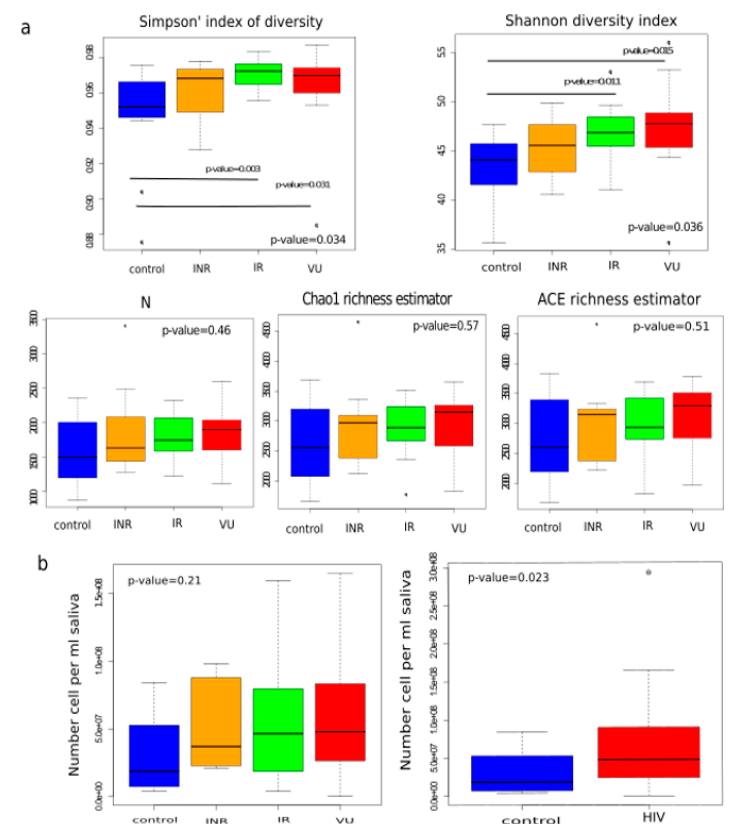
Figure 3. Alpha diversity and bacterial load in saliva. ( a ) Simpson’s index of diversity, Shannon diversity index, number of OTUs observed ( N ), Chao1 richness estimator, and Abundance-based Coverage Estimator (ACE) in the four groups. ( b ) Bacterial load expressed as number of cells per mL of saliva in the four groups. and bacterial load expressed as number of cells per mL of saliva in HIV-infected individuals (HIV) and controls. To calculate di ff erences across groups, we used the Kruskal–Wallis test ( p -value = 0.05) and, for di ff erences between groups, we used the Wilcoxon rank-sum test ( p -value = 0.05). INR, immunological ART non-responders (yellow); IR, immunological ART responders (green); VU, viremic untreated (red); and controls